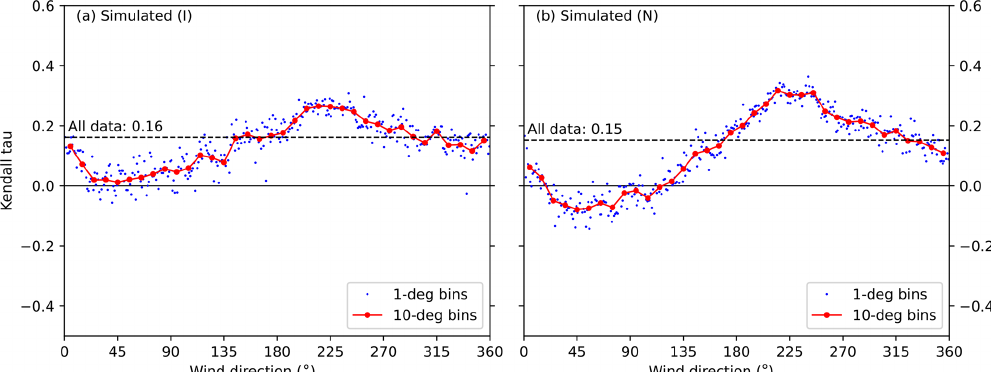
Figure B1. The Kendall correlation coefficients ( τ ) between significant wave height and sea level for different wind directions. The blue dots show correlation in 1 ◦ direction bins, and the red dots in 10 ◦ bins. The significant wave heights from simulated data sets (a) I and (b) N 1992–2019 are shown. The direction given is the direction from where the wind blows (nautical convention), observed at Harmaja weather station. The correlation coefficients for all data ( τ = 0 . 16 and 0.15) are shown as horizontal